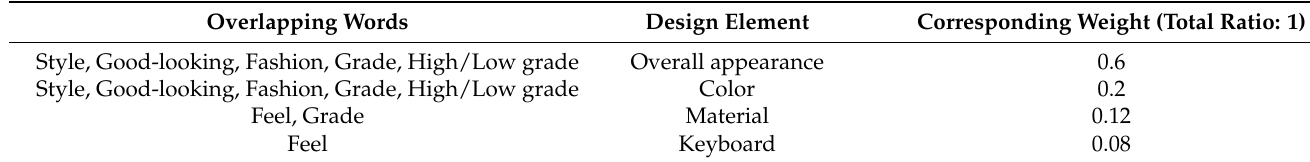
Table 5. Weight distribution of overlapping words.